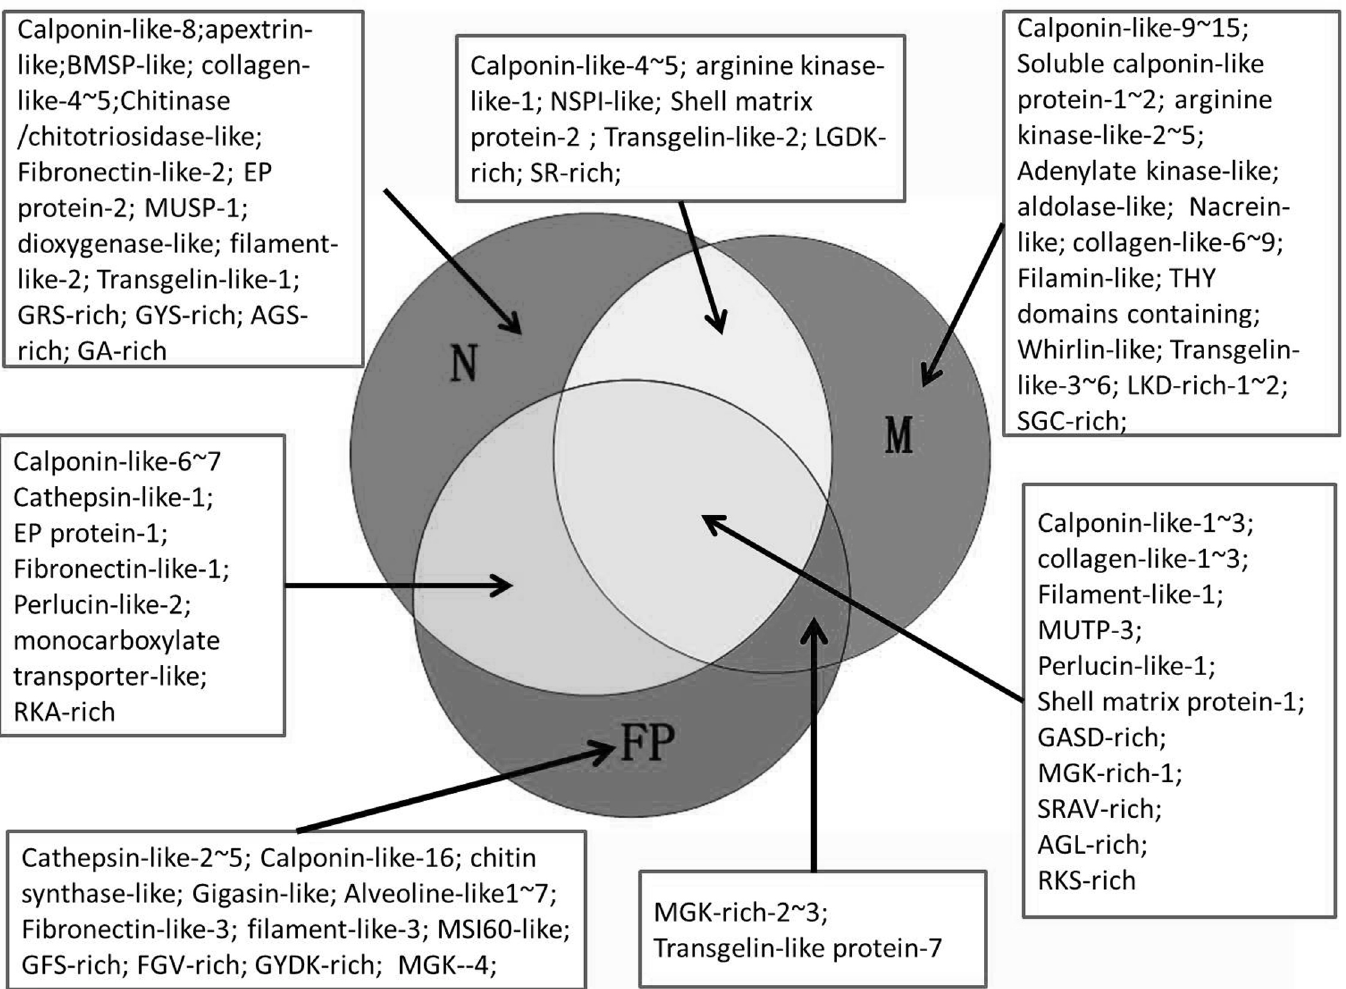
Fig 4. The distribution pattern of identified proteins in three shell layers of M . galloprovincialis . The proteomic data comprises identifications occurring in both soluble fraction and insoluble fraction from all three layers. N, M, and FP represent nacre, myostracum, and fibrous prism,